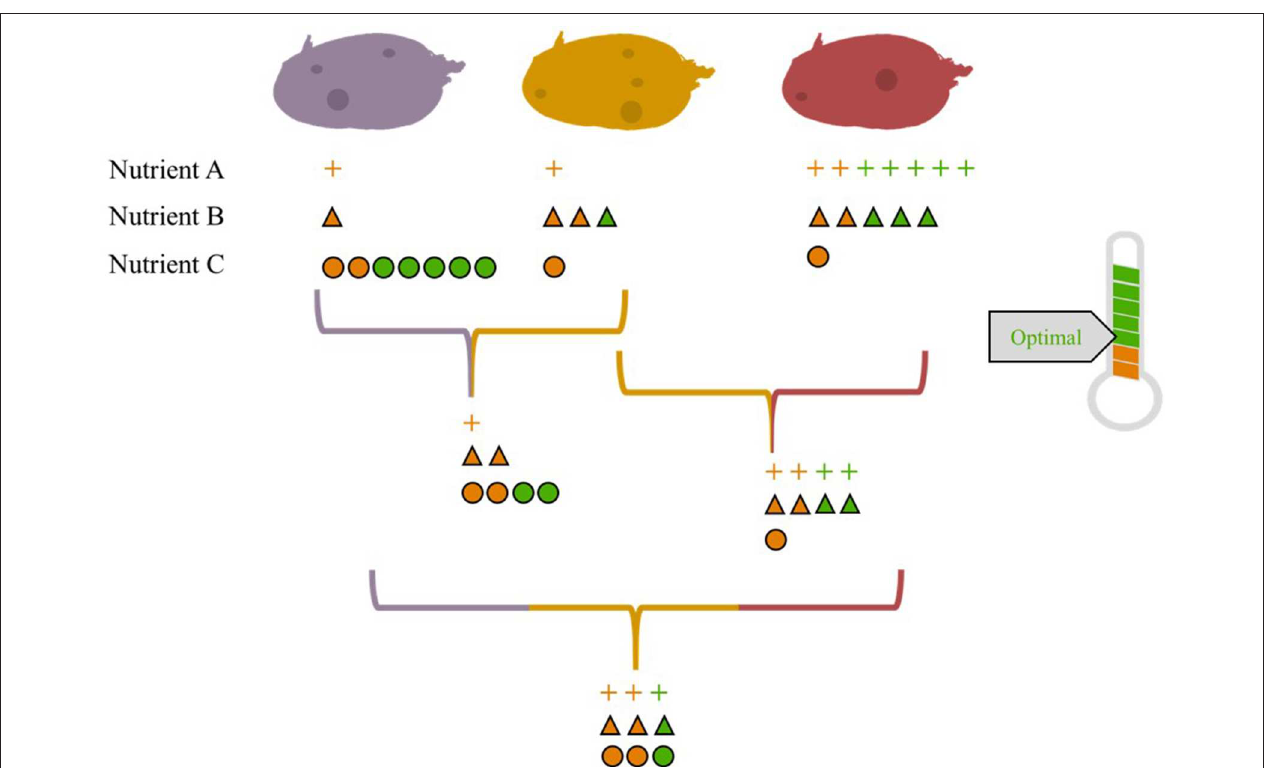
FIGURE 2 | In this illustration, we show three hypothetical varieties of potato (purple, yellow, and red) that have varying levels of nutrients A, B, and C. A field planted to two or three of these varieties provides a more balanced nutrient profile relative to a field planted with one variety. Based on the assumption that individuals would consume the same quantity of potatoes regardless of variety, we show the average level of each nutrient provided by two- and three-variety mixtures. In this hypothetical example, three units of each nutrient are needed to achieve the daily recommended intake. Green indicates optimal nutrient levels that meet this requirement, while orange indicates sub-optimal nutrient